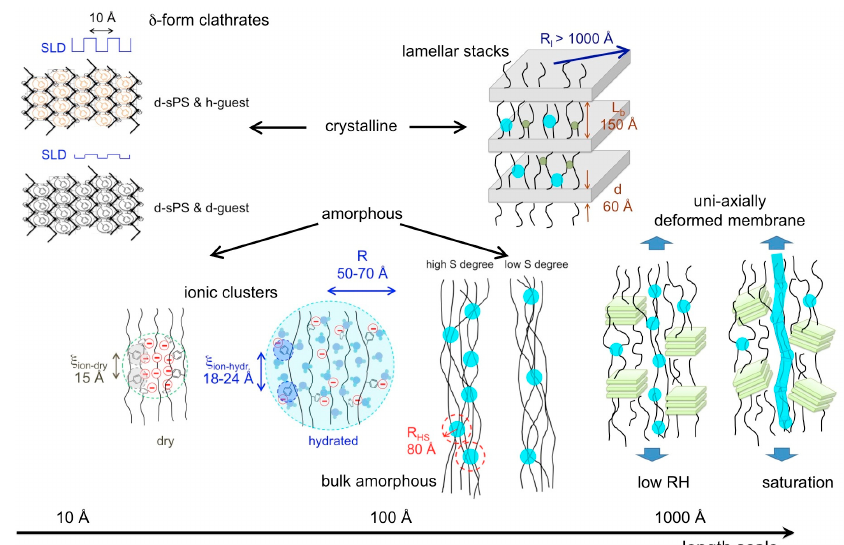
Figure 9. Structural levels that form on the length scale between nm and μ m in dry and hydrated membranes based on semi-crystalline s-sPS, as identified and characterized by contrast variation SANS. The turquoise full circles distributed in the bulk and interlamellar amorphous regions represent the hydrated ionic clusters, while the green small dots in in the interlamellar amorphous layers are the still dry ionic clusters. At very high hydration levels (saturation), water channels are formed in the bulk amorphous regions [28].